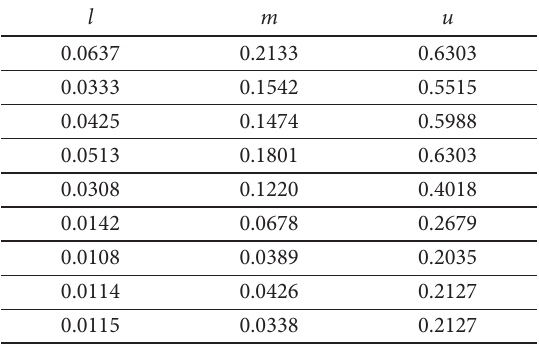
Table 1. The degree of possibility of